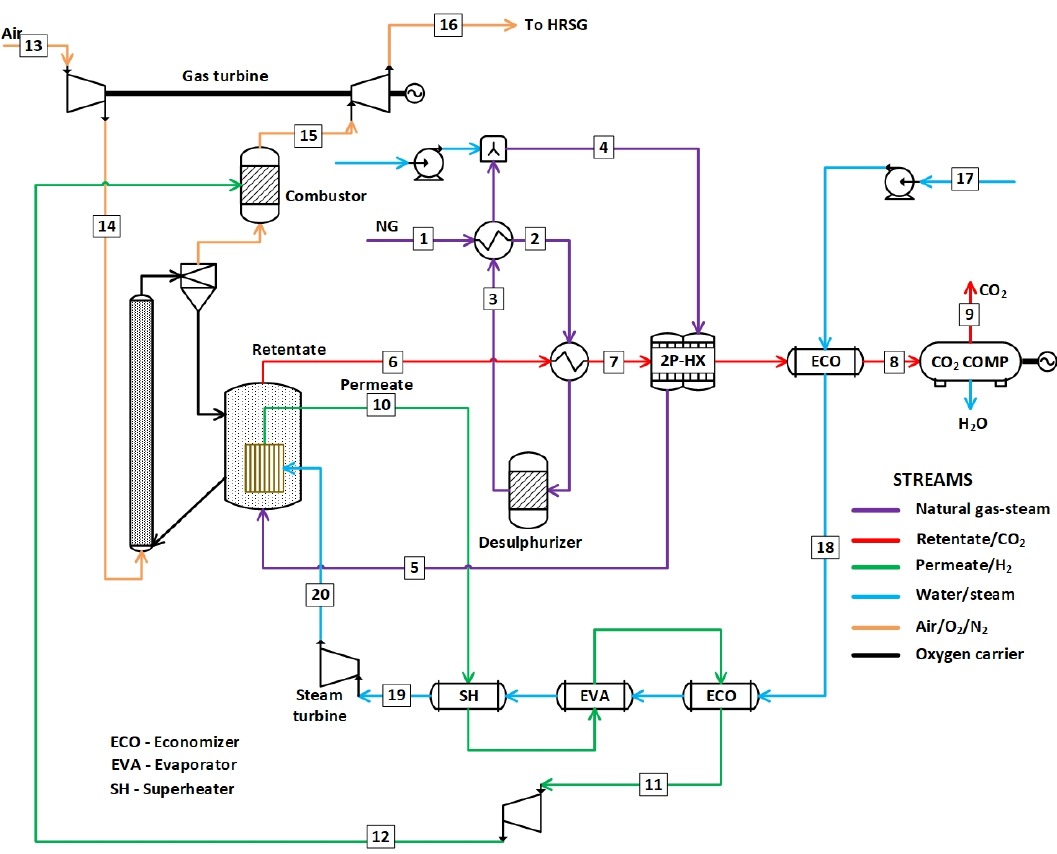
Figure 7. Schematic of case 5 (all H 2 is used in combustor). Stream numbers refer to stream details listed later in Table 4.